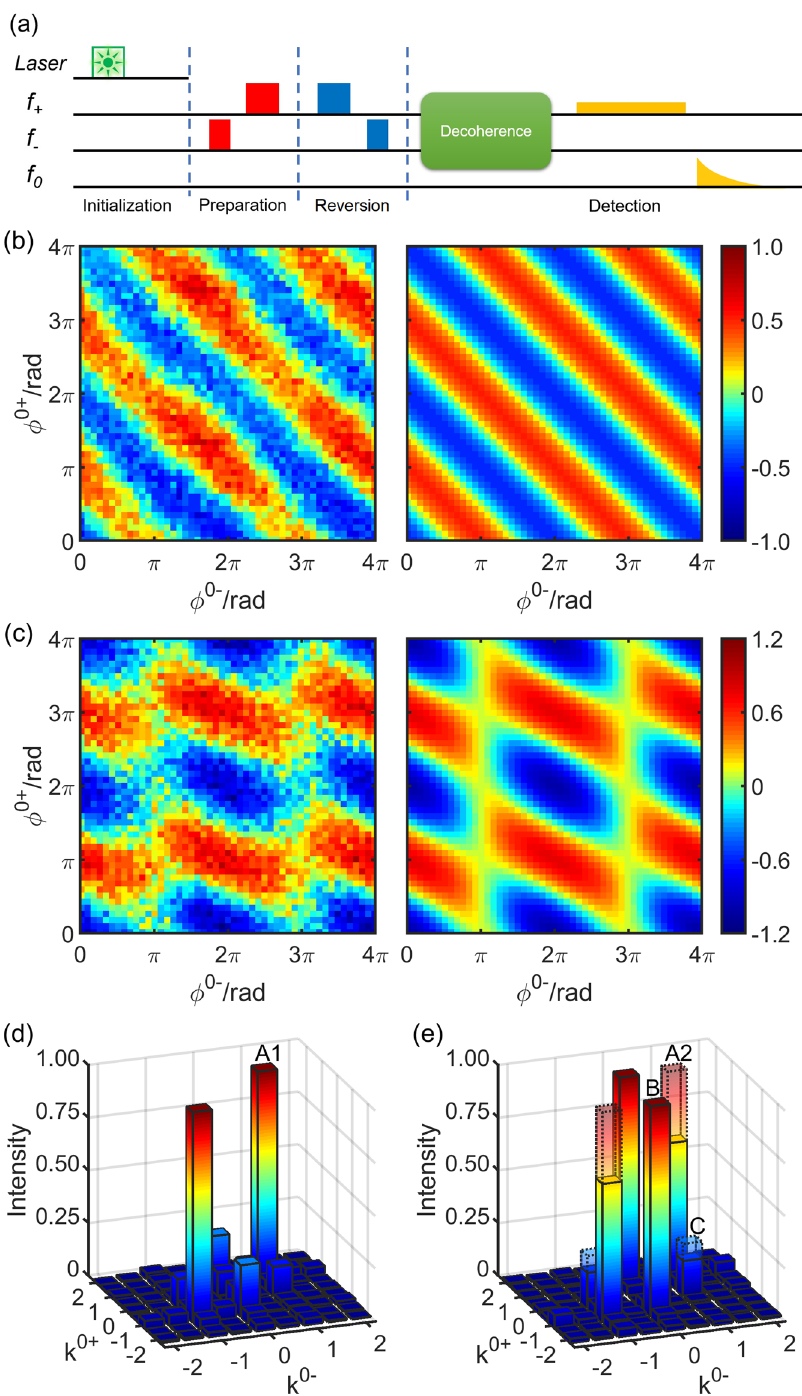
Fig. 3 Quantum phase interference. a The pulse sequence. b , c Measured (left) and simulated (right) patterns of M 0 + as a function of ϕ 0 + and ϕ 0 − for ψ 1 j i and ψ 2 j i . d , e The 2D Fourier transformations of interference patterns ( b ) and ( c ), with solid bars showing the experimental data and dashed ones the simulation results. For clarity, only low-frequency data are shown and the heights are